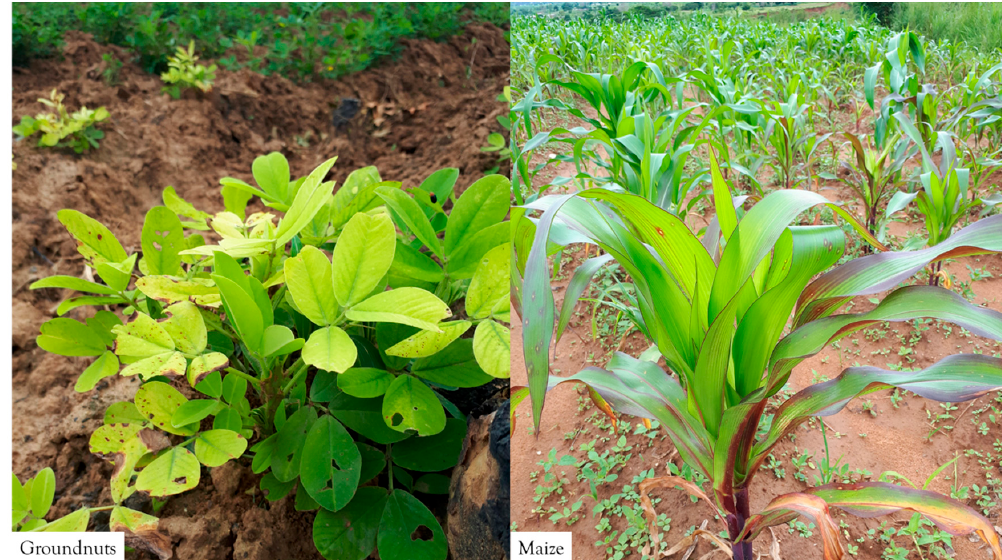
Figure 6. Discoloration of crops as observed by some farmers. Farmers expressed that such discolorations are due to the deficiency in some nutrients and such deficiencies could potentially affect yield.